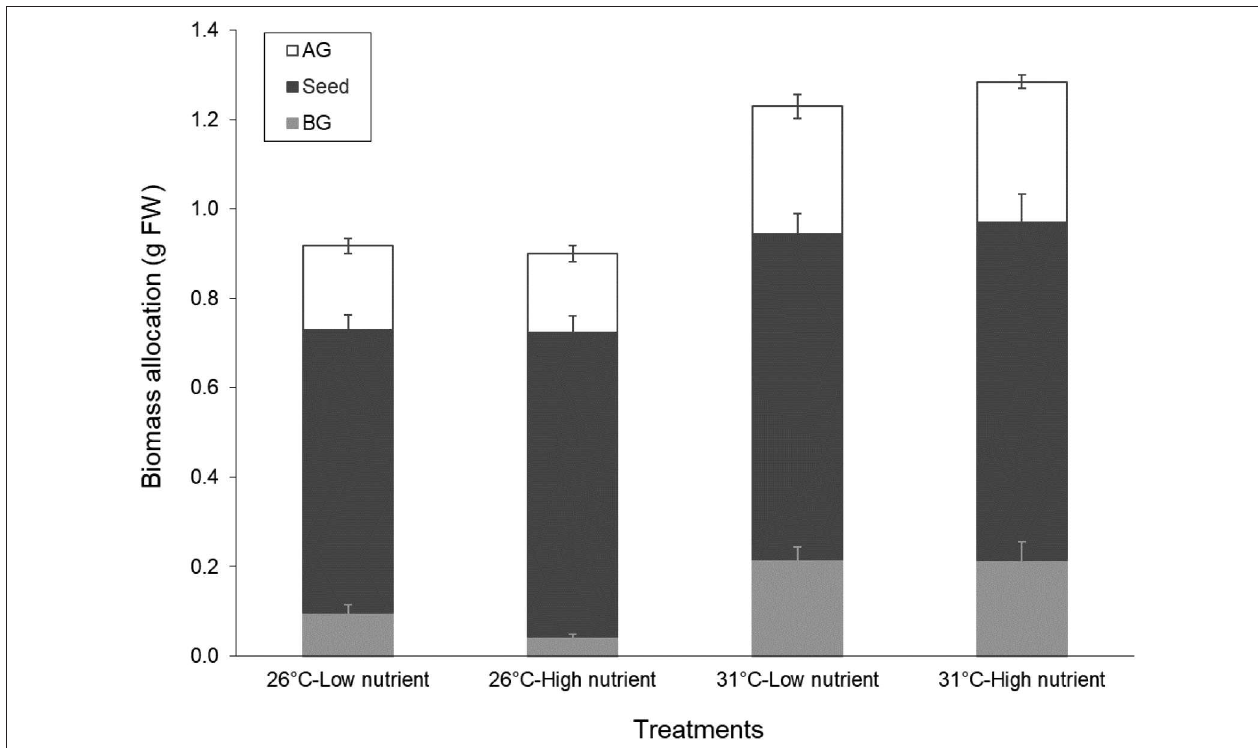
FIGURE 2 | Allocation of above-ground (blades, AG), seed, and below-ground (roots, BG) biomass in the seedlings of Enhalus acoroides in the four different temperature and nutrient treatments at the end of the experiment. Values are mean ± SE ( n = 6). Statistical results are shown in Table 4